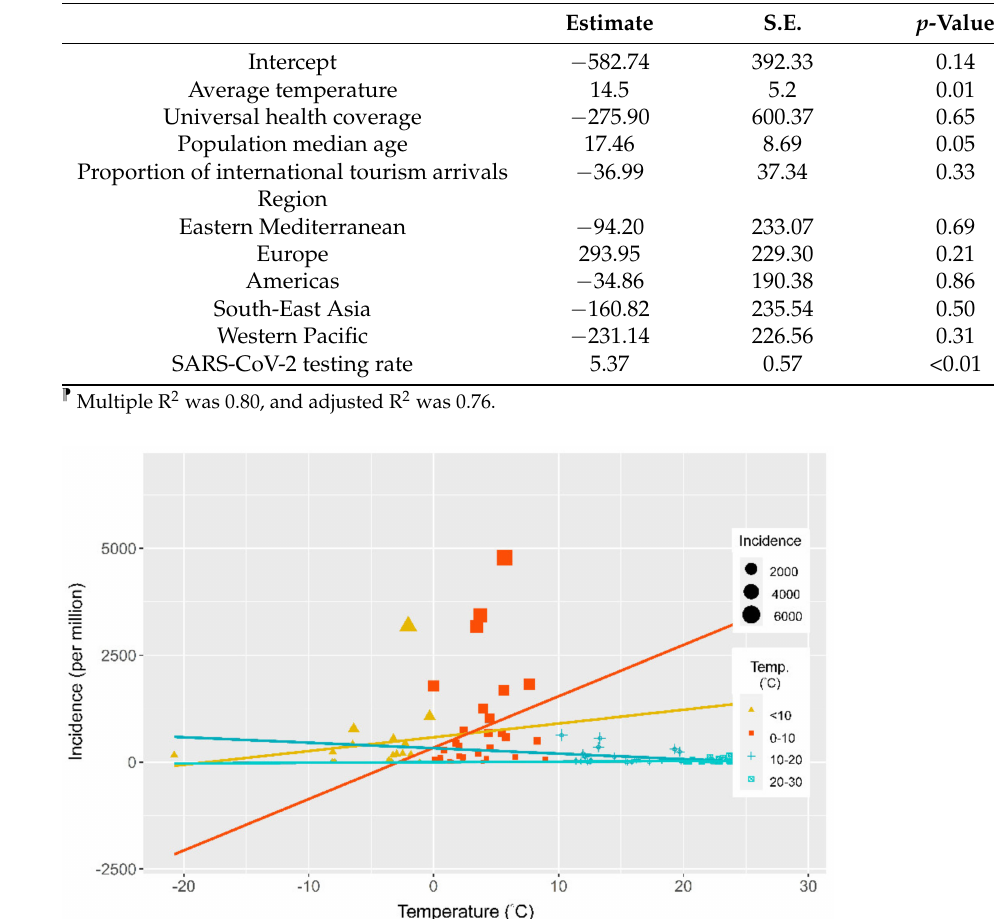
Figure 4. The incidence rates of four temperature